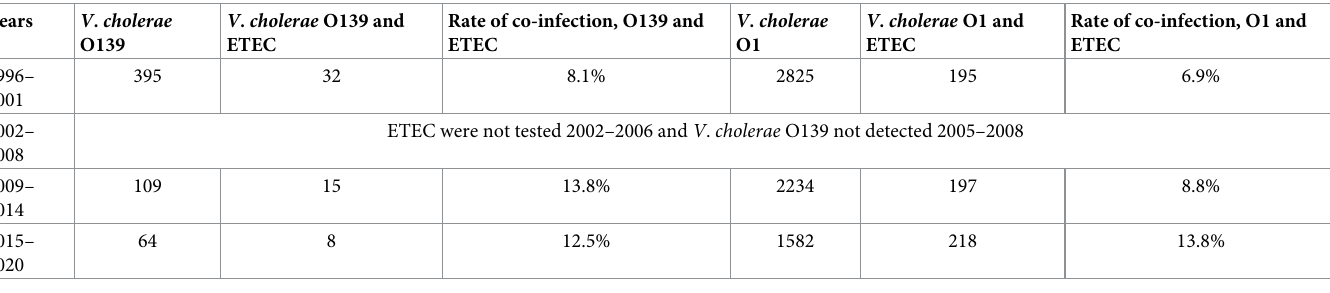
Table 4. Co-infections of Vibrio cholerae 0139 and enterotoxigenic E coli among diarrhoeal patients attending the Dhaka Hospital of icddr,b, Bangladesh (1996–